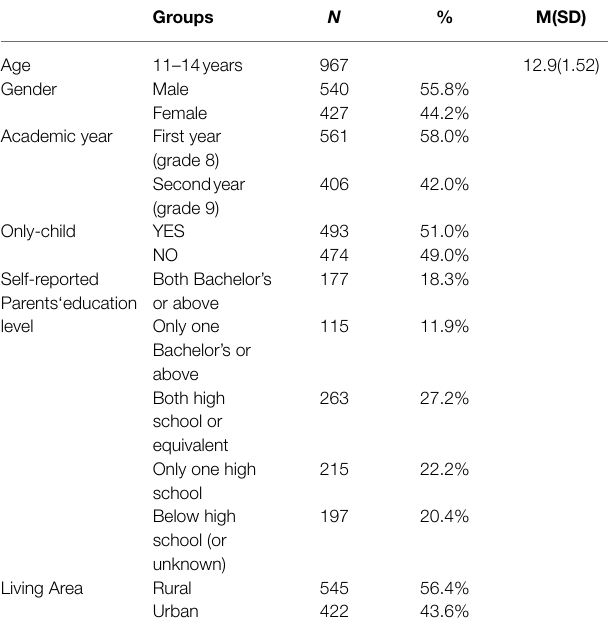
TABLE 1 | Sociodemographic characteristics of the sample ( N =